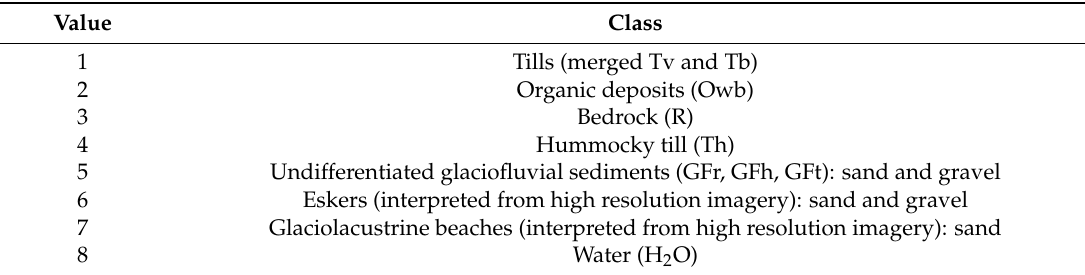
Table 2. Merged legend referred to as Legend 2.